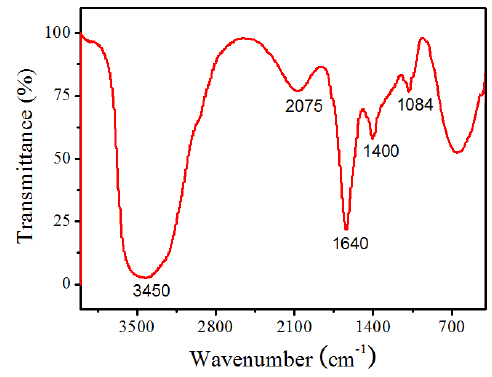
Figure 5. Fourier Transform Infrared spectra of the FCNs.